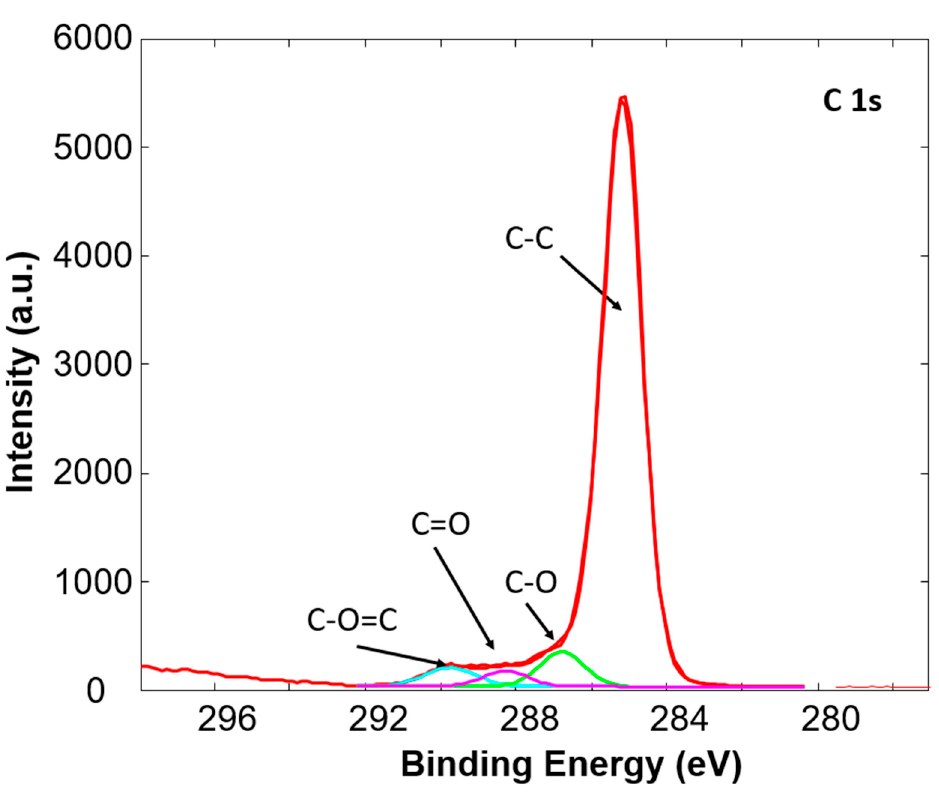
Figure 2. High resolution XPS spectra of untreated Sample 3.